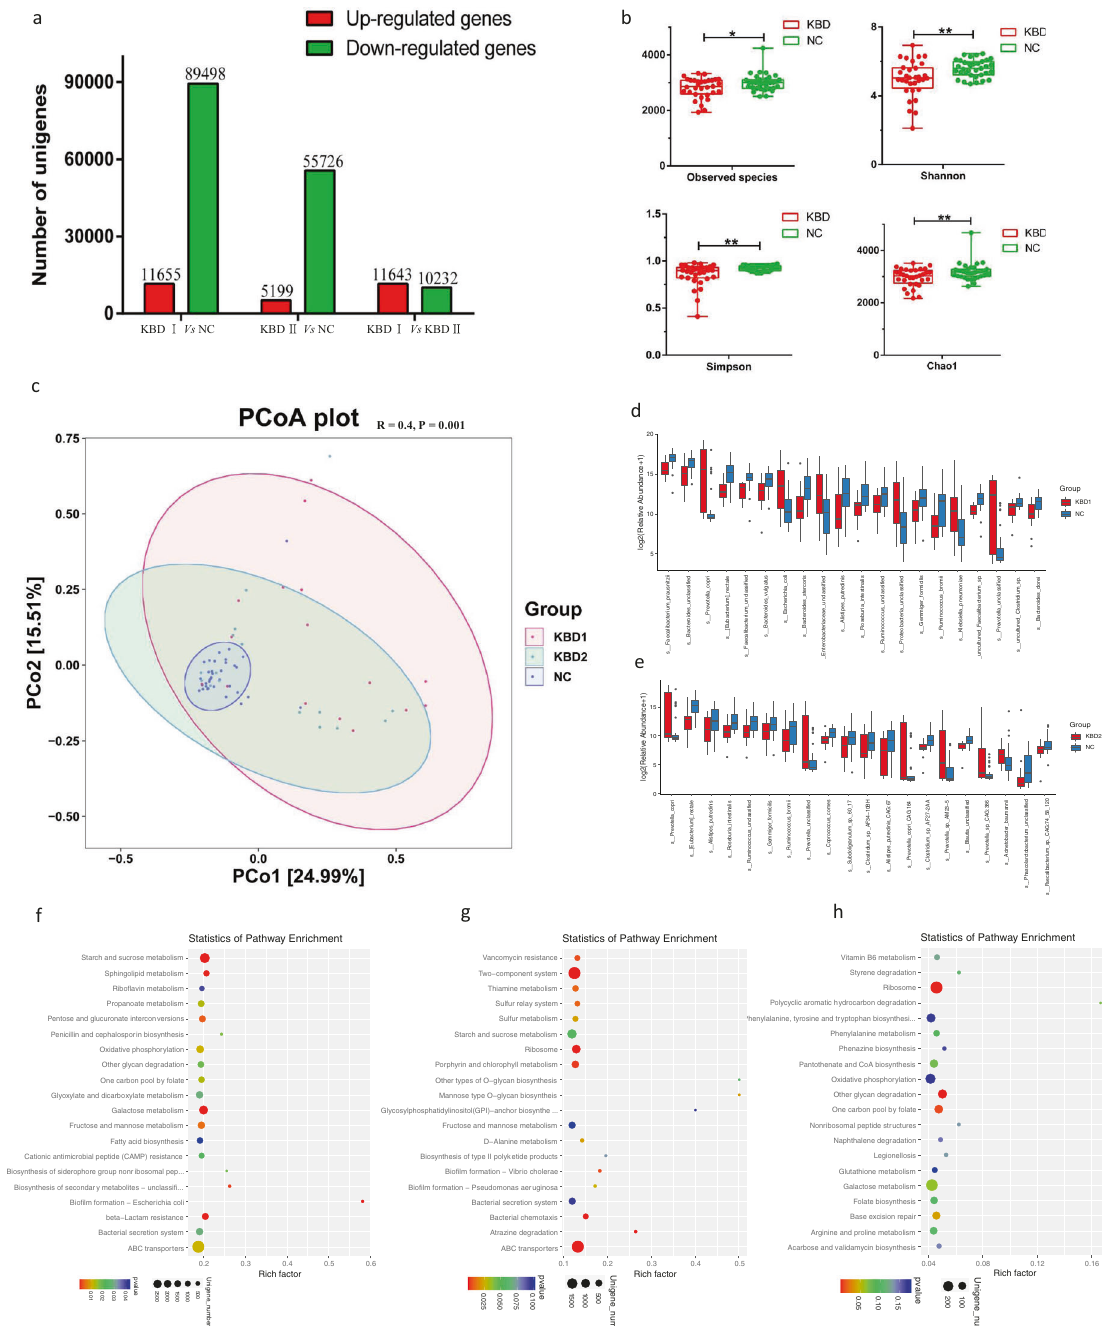
Fig. 3 The gut microbiota differences in grade I, II KBD, and NC group based on the metagenomic sequencing data. a Differential expressed unigenes among KBD grade I, II, and NC group. b Alpha diversity differences between the KBD and NC groups were estimated by the observed species, Shannon, Simpson, and Chao1 indices. * P < 0.05, ** P < 0.01. KBD, patient with KBD group; NC, normal control group. c The PCoA analysis based on the Bray-Curtis distance matrix between the grade I, II KBD, and NC group at the species level (ANOSIM, R = 0.4, P = 0.001). d , e The relative abundance of top 20 species enriched in grade I KBD versus NC. The relative abundance of top 20 species enriched in grade IIvKBD versus NC. The box represents the interquartile ranges, inner line denotes the median. f – h Pathway classi fi cation based on KEGG enrichment analysis of differentially expressed unigenes between grade I KBD and NC ( f ), grade II KBD and NC ( g ), grade I KBD and grade II KBD ( h ). Rich factor, the ratio of the number of DEGs to the number of total genes in this pathway. Genes with mRNA showing at least a twofold change are shown; adjusted P < 0.05 for all data